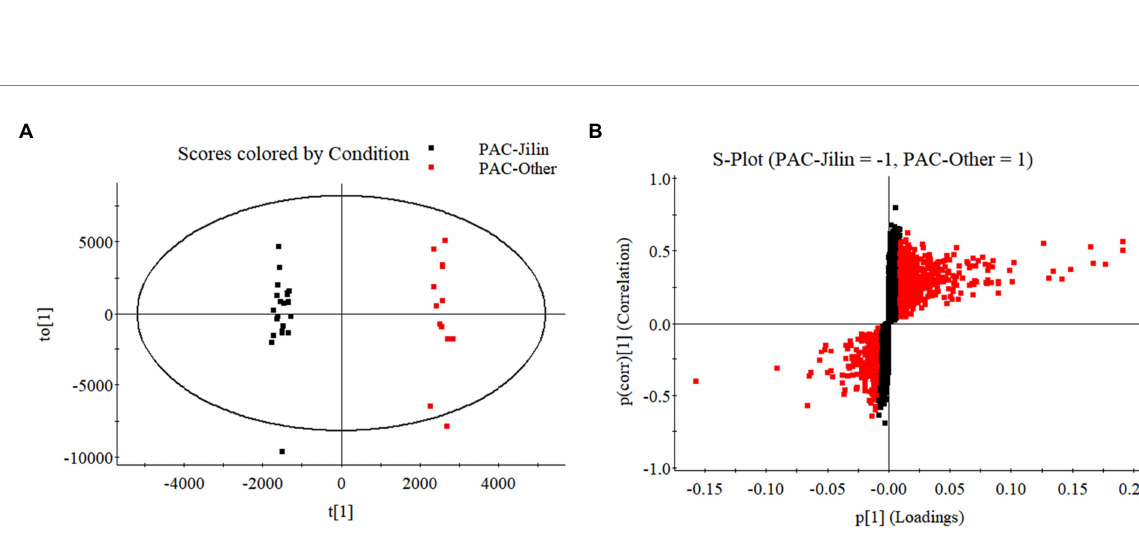
physalins. Quantitative analysis of all components was